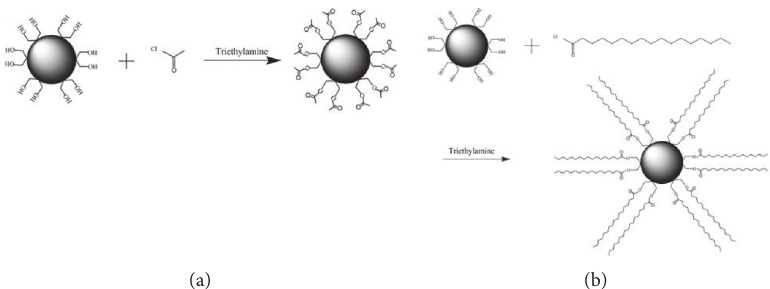
Figure 6: Synthesis of H102 with terminated acetyl end groups (H102-C (b)